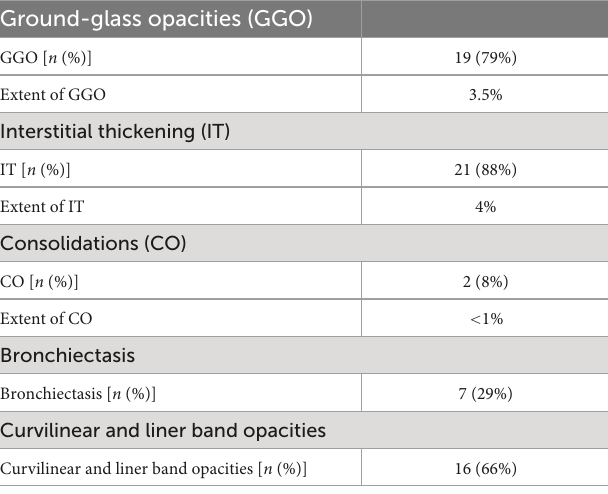
TABLE 2 Chest high resolution computed tomography (HRCT) scan characteristics of the not-recovered (NOT-REC) group ( n = 24) at 12-month.